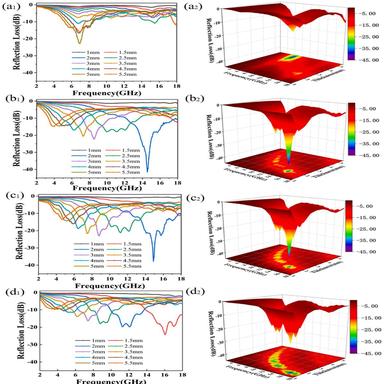
RL curves and 3D maps of Fe3O4@PS -1/MWCNT (a), Fe3O4@PS -2/MWCNT (b), Fe3O4@PS -3/MWCNT (c), and Fe3O4/MWCNT(d).